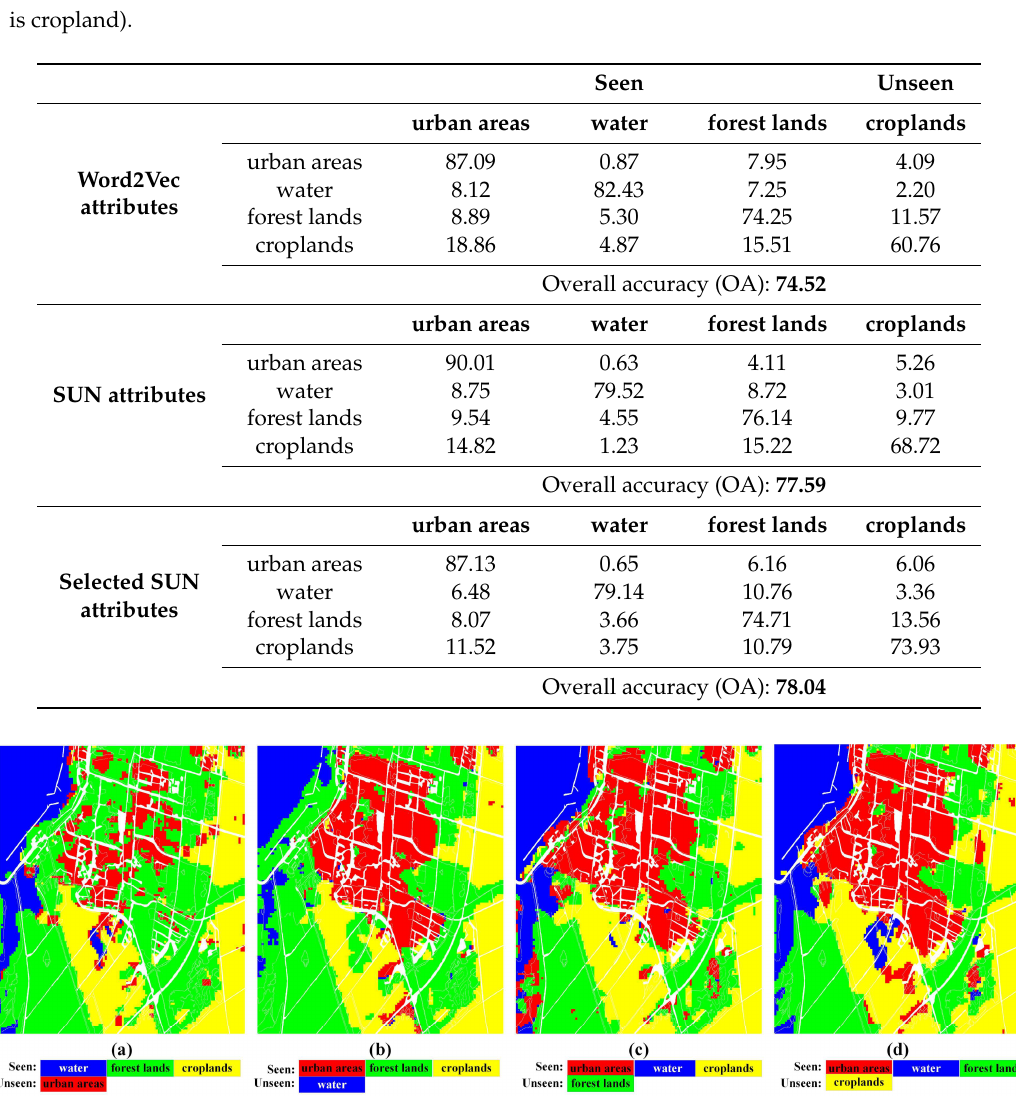
Figure 5. The GZSL classification results of the Flevoland data with different unseen classes. ( a ) The results of the unseen class with urban areas; ( b ) the results of the unseen class with water; ( c ) the results of the unseen class with forest lands; and ( d ) the results of the unseen class with croplands.